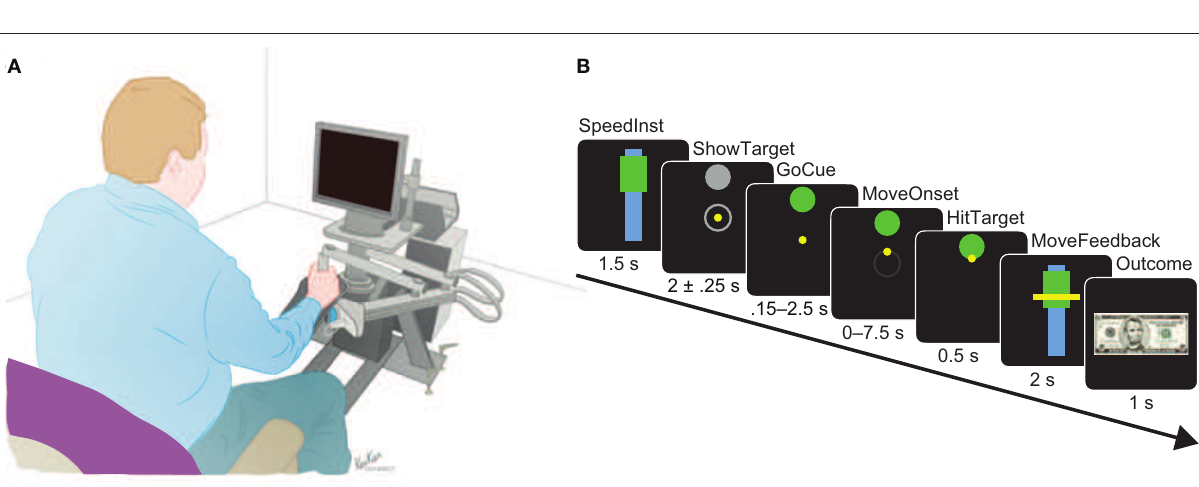
FIGURE 2 | (A) Apparatus set-up of the robotic manipulandum and attached screen, where the visual stimuli for the motor task were displayed. This system allowed for precise tracking of arm movements over a horizontal plane as the subjects controlled a cursor shown on the screen with the task stimuli. (B) Detailed timeline of epochs during a single trial shown using simulated screens. The interval of time in which the stimuli were presented are shown below each simulated epoch. Models were built using the neural activity recorded between MoveOnset and